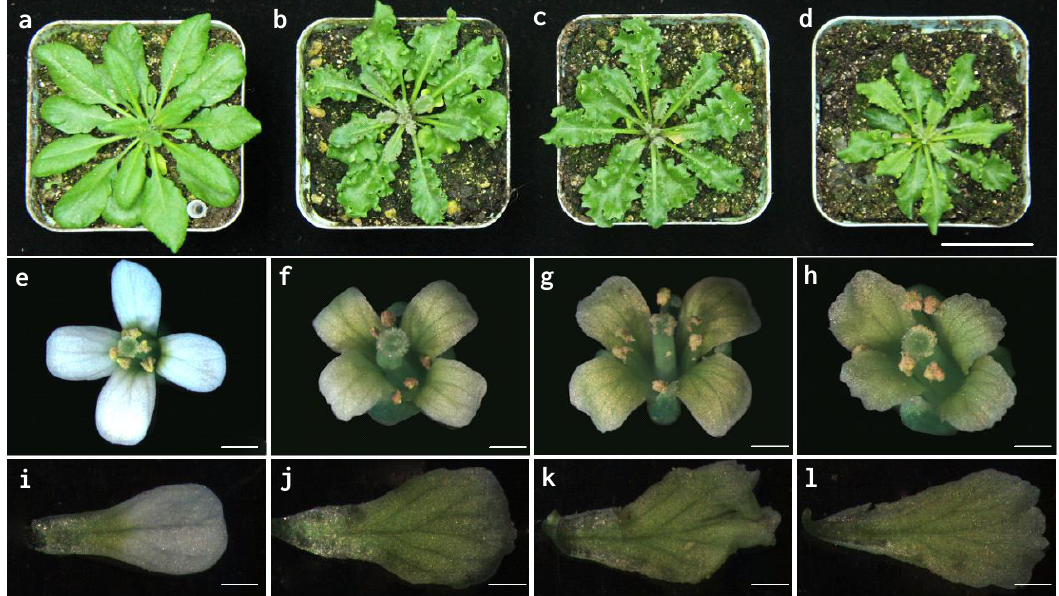
Figure 2. Phenotype of Bra-MIR319 family overexpressing transgenic Arabidopsis . ( a – d ) Rosette plants of wild-type and overexpressing the Bra-MIR319a , Bra-MIR319b , and Bra-MIR319c , respectively. ( e – h ) The flower of wild-type plant and transgenic Arabidopsis overexpressing the Bra-MIR319 family, respectively. ( i – l ) The petal of wild-type plant and transgenic Arabidopsis overexpressing the Bra-MIR319 family, respectively. Scale bars, 2 mm in ( a – d ), 1 mm in ( e – l ).